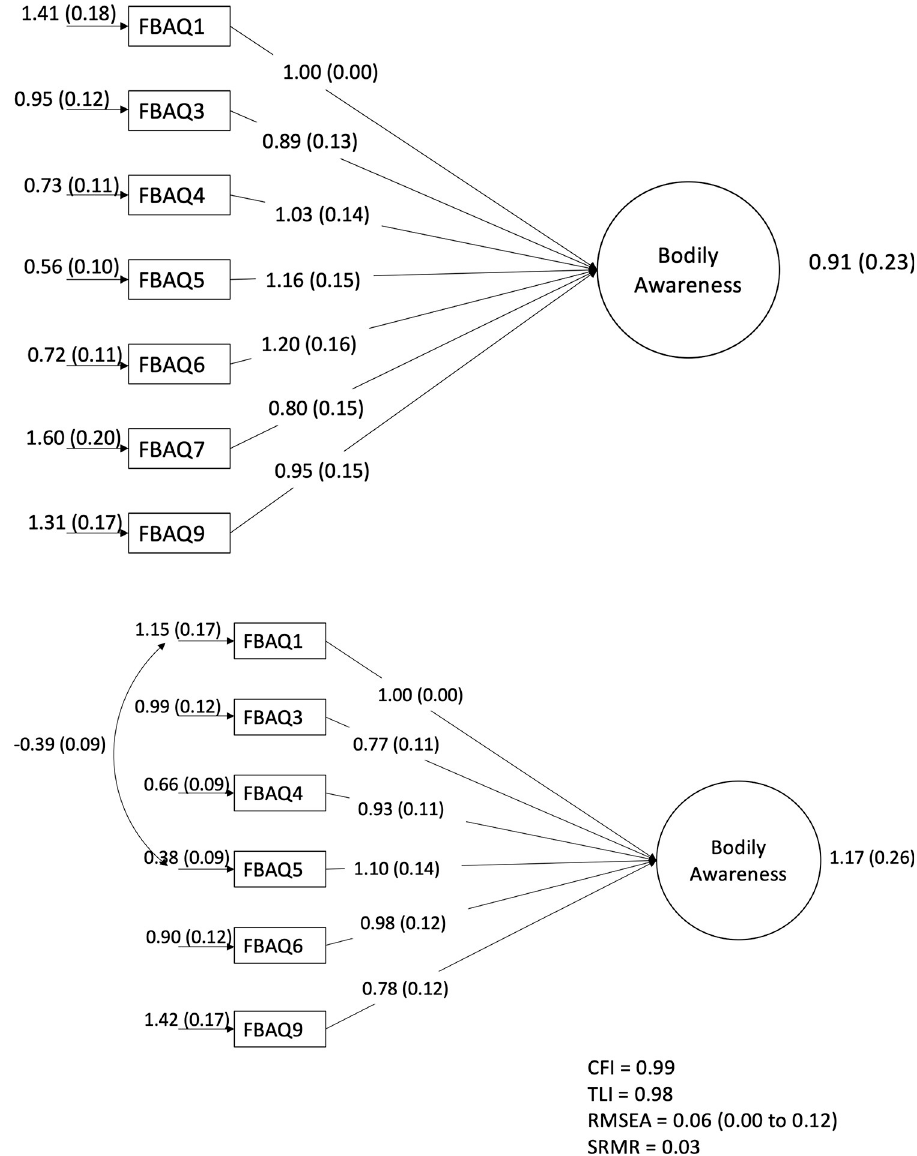
Fig 1. a: Base model for confirmatory factor analysis (CFA) including all of the original FreBAQ items. Values are path coefficients (standard error). b: Final CFA model after removal of poorly-fitting items. Values are path coefficients (standard